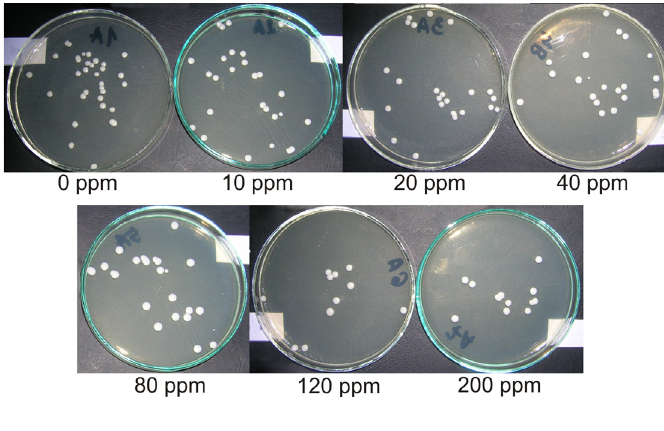
Figure 4. Example results of antifungal tests against Candida albicans after 17 h of incubation with UG and UG SC/AgNP